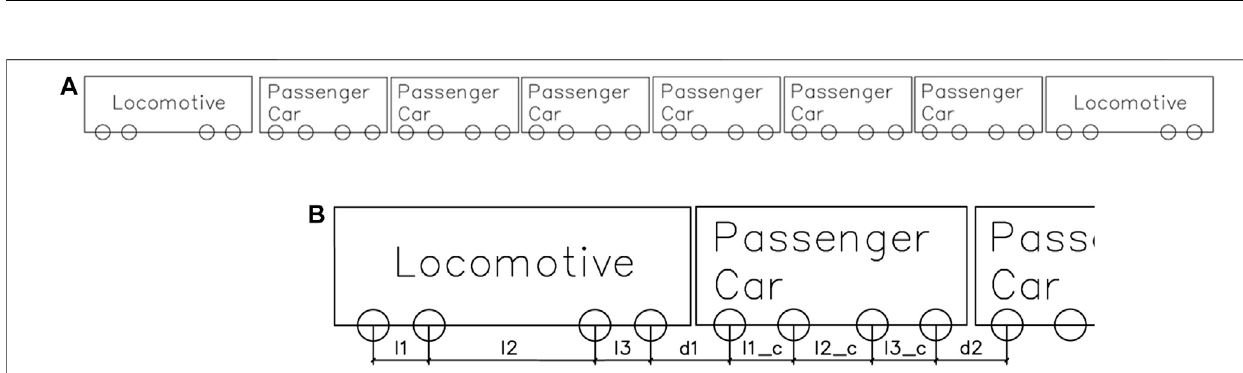
Frontiers in Built Environment |